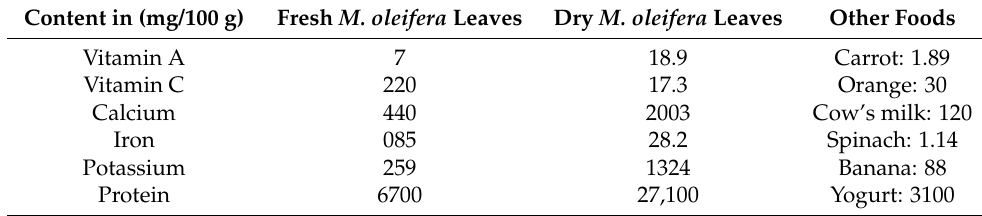
Table 1. Nutritional value of fresh and dried M. oleifera leaves compared to other foods (Sources: [31,46]). Content in (mg/100 g)